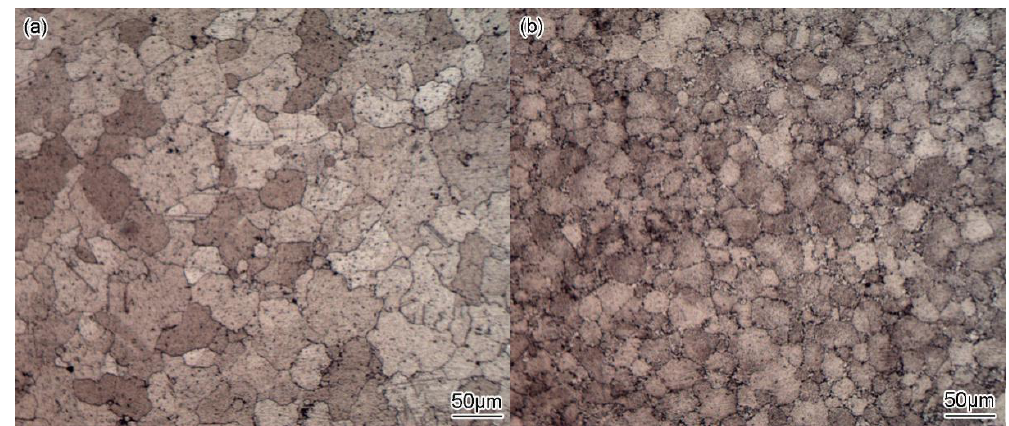
Table 3. Density and relative density of FGH100L alloys under different